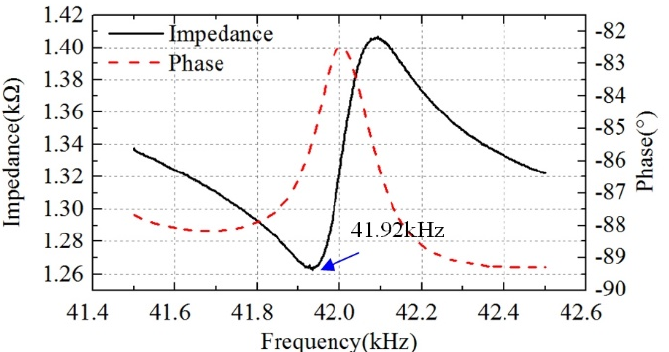
Figure 6. The impedance characteristics.